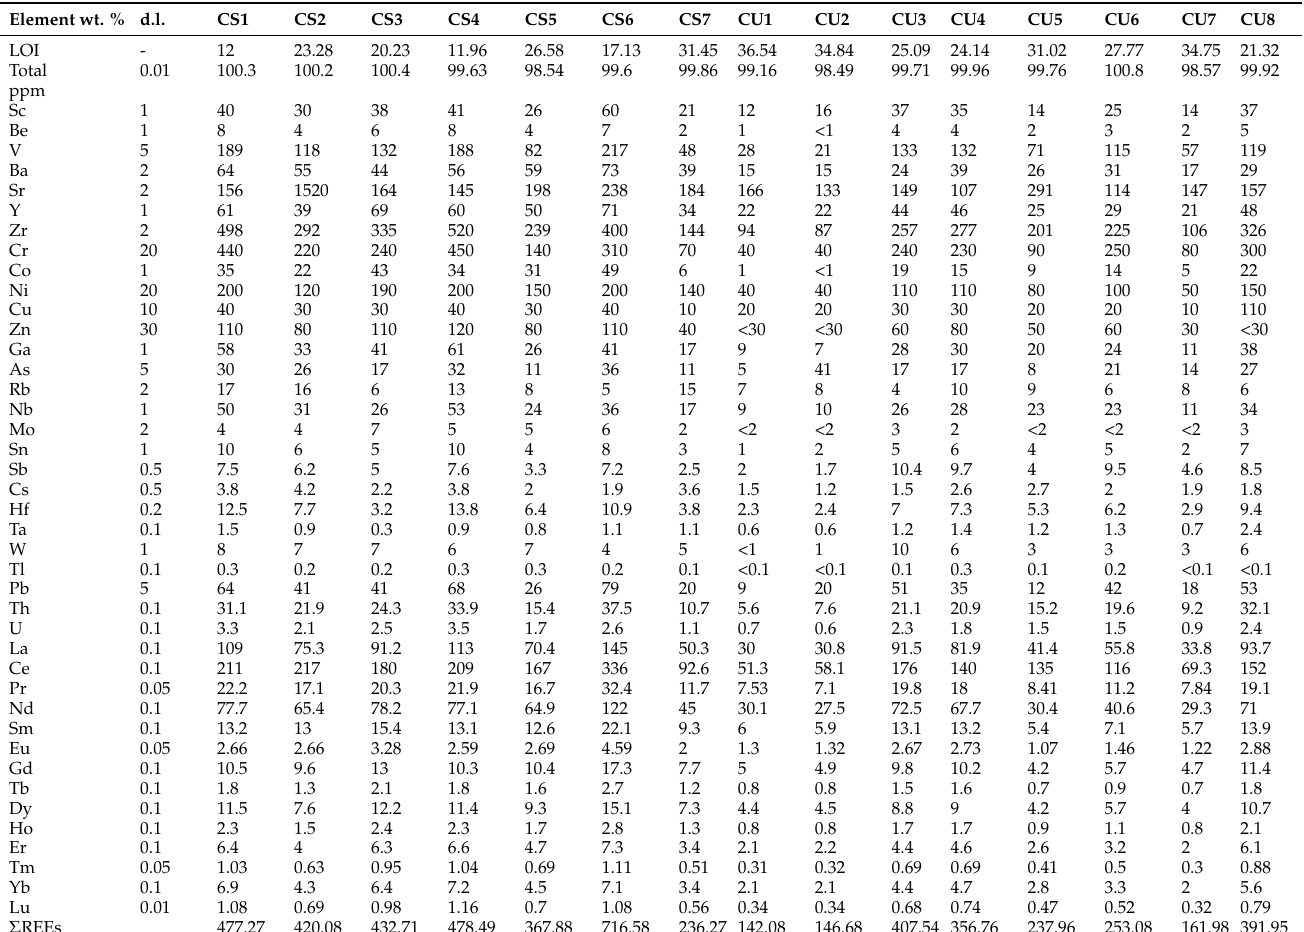
Figure 8. Chondrite-normalised REEs patterns of studied bauxites. 5. Discussion 5.1. Image Analysis in Bauxites Image analysis represents a valuable approach for analysing the properties of a dif- ferent range of structures ranging from molecules and atoms to the coastlines of conti- nents [35], and the aggregation of small particles to form larger structures, such as the formation of minerals, can be described in terms of fractal geometry [36]. The growth of sub-circular concretions, such as ooids within bauxites, is a chemical transport-controlled